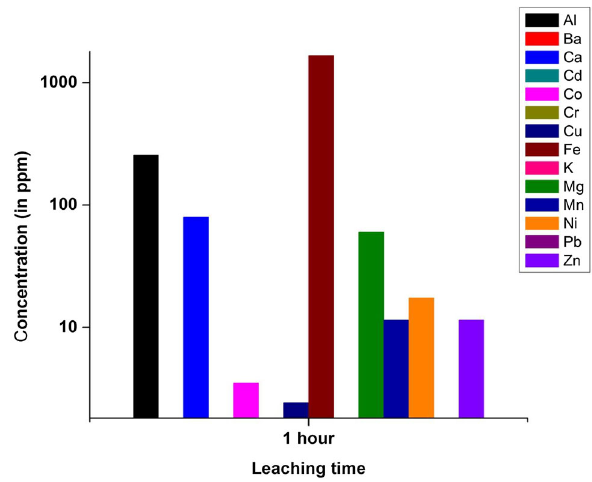
Fig. 27 Change in elemental concentration (in ppm) in aqueous leachates of Ledo coal (LC-20A) with leaching time (in hour) at 65 (cid:3) C